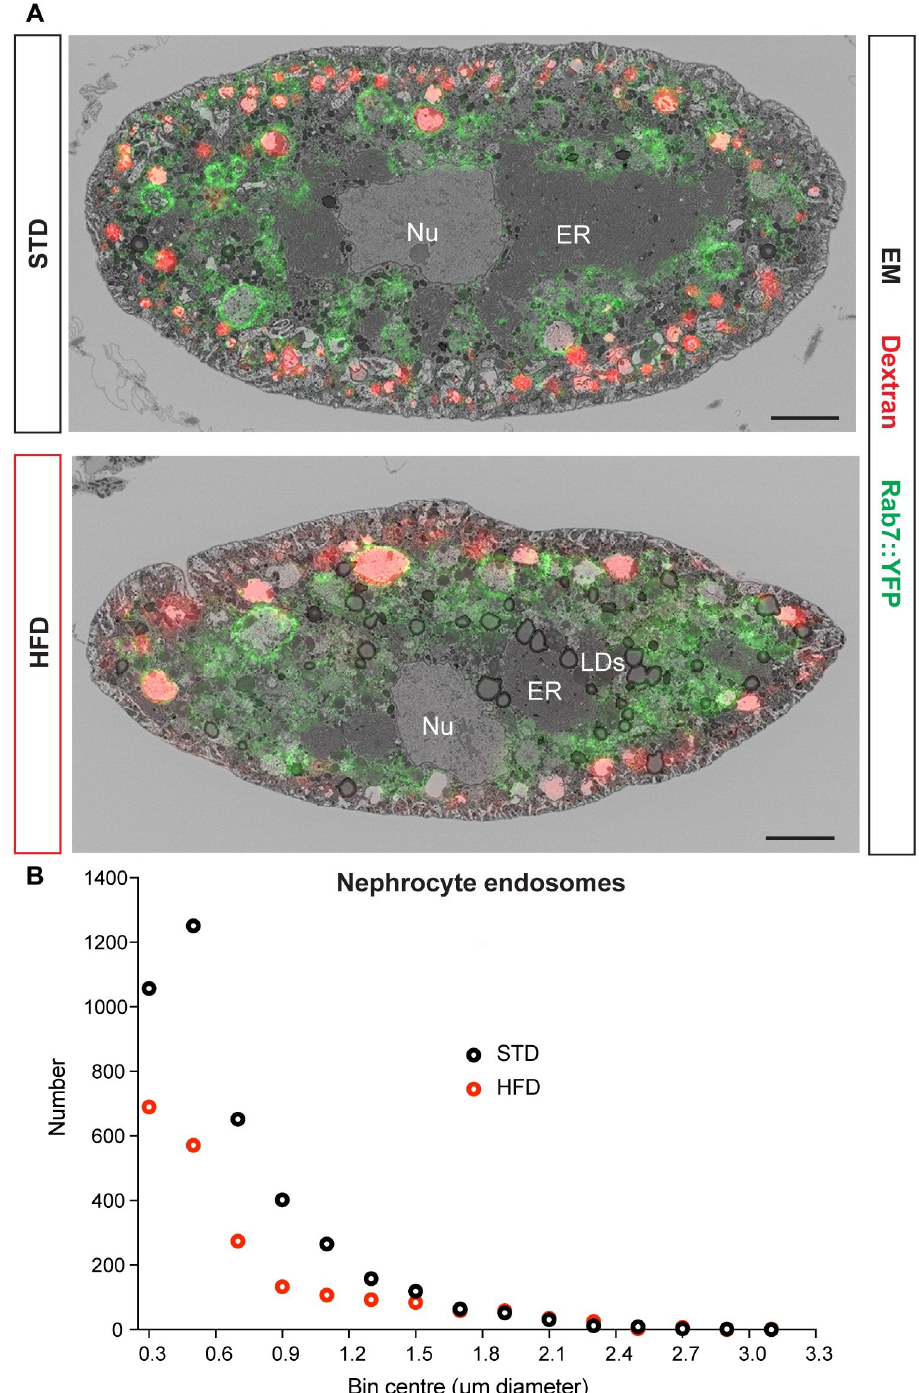
Fig 3. HFD decreases the number of nephrocyte endosomes. ( A ) CLEM images of midsections of STD and HFD nephrocytes expressing Rab7::YFP myc and labelled with Alexa Fluor 568 10 kDa dextran. Scale bars are 5 μ m. ( B ) Distribution of endosome number versus diameter for 1 STD and 1 HFD nephrocyte segmented by SBF SEM according to the “white” and “light” classifications in S3A Fig . See S1 Data for details of p -values and the type of statistical model used for all graphs in this study. S2 Data provides the source data used for all graphs and statistical analyses. CLEM, correlative light electron microscopy; ER, endoplasmic reticulum; HFD, high-fat diet; LD, lipid droplet; SBF SEM, serial blockface scanning electron microscopy; STD, standard